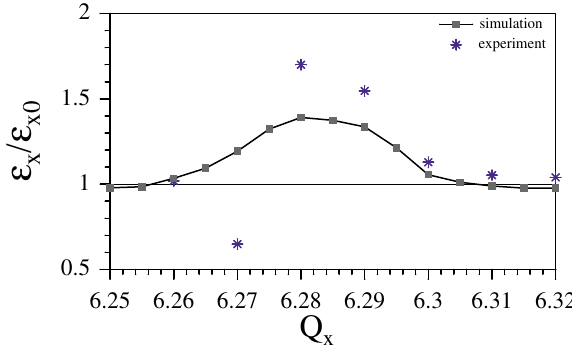
FIG. 4. (Color) Result of fully self-consistent 2D simulation with 5 (cid:1) stronger octupole (200 A) after 1000 turns. Shown are rms emittances and total intensity in units of initial